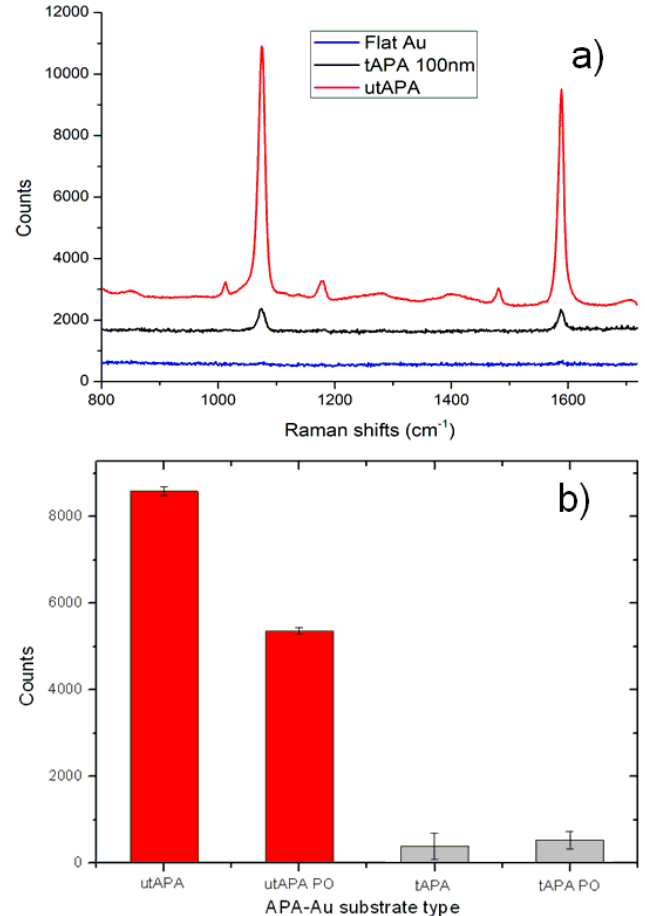
Figure 3. ( a ) Typical Raman spectra of test probe molecule mercaptobenzoic acid (MbA) on utAPA-Au (red) tAPA-Au (black) and Au (blue); ( b ) Peak intensity at 1076 cm − 1 extracted from the Raman spectra of test probe molecule MbA on different substrates of tAPA and utAPA, before (no suffix) and after pore opening (PO suffix). Bars are mean ± standard deviation ( N = 8).